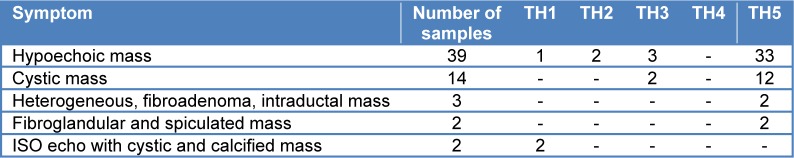
Classifying the subject samples based on symptom types and their standard Thermo-biological scores